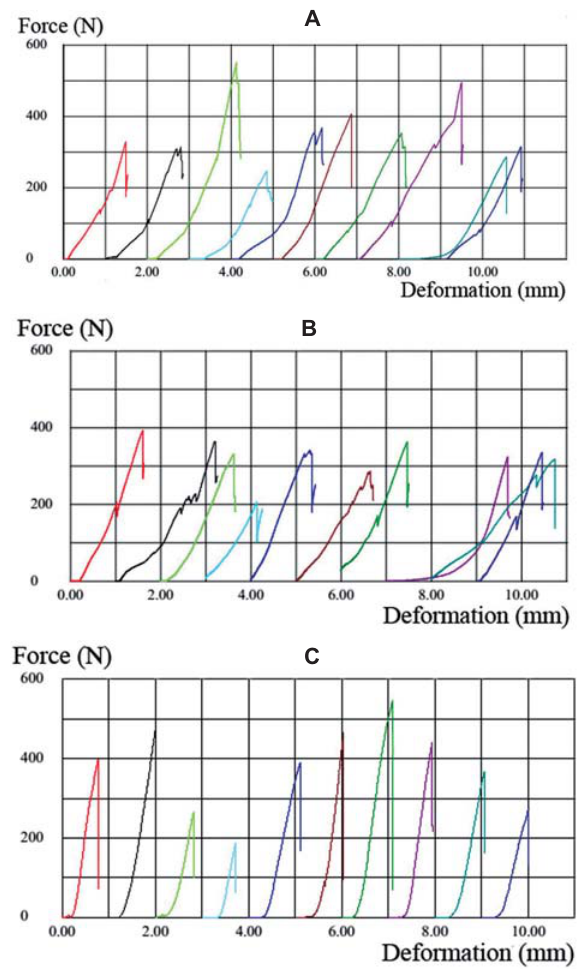
Figure 3- Graphics of groups addition silicone (A), polyether (B), and control (C) illustrating the force (N) and deformation (mm) of each specimen during the fracture (cid:6)(cid:15)(cid:13)(cid:5)(cid:17)!(cid:15)(cid:4)(cid:9)(cid:15)(cid:5)(cid:6)(cid:15)"(cid:9)#(cid:17)(cid:9)(cid:15)(cid:4)(cid:5)(cid:9)!(cid:13)(cid:20)(cid:12)(cid:19)(cid:6)(cid:9)(cid:16)(cid:7)(cid:15)(cid:4)(cid:9)(cid:2)(cid:17)(cid:9)(cid:2)(cid:13)(cid:15)(cid:7)(cid:18)(cid:25)(cid:7)(cid:2)(cid:11)(cid:9)(cid:19)(cid:5)(cid:13)(cid:7)(cid:20)(cid:3)(cid:20)(cid:17)(cid:15)(cid:2)(cid:11)(cid:9) ligament, the specimens are accommodated when a load is applied. This is not observed in group C because of the rigidity of the acrylic resin, and the graphic is a crescent line until the failure threshold of the restorative assembly is